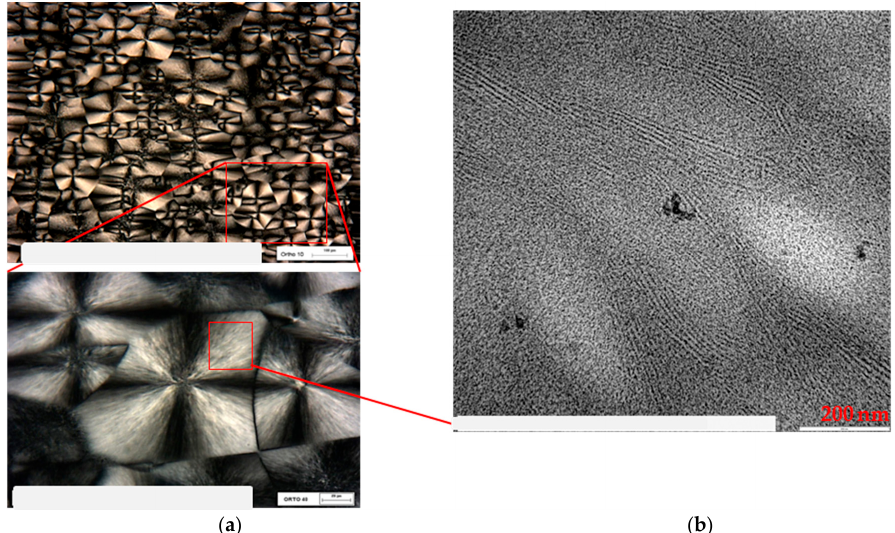
Figure 11. POM image of PB1 ( a ) at different magnification, and TEM image of the selected area ( b ).